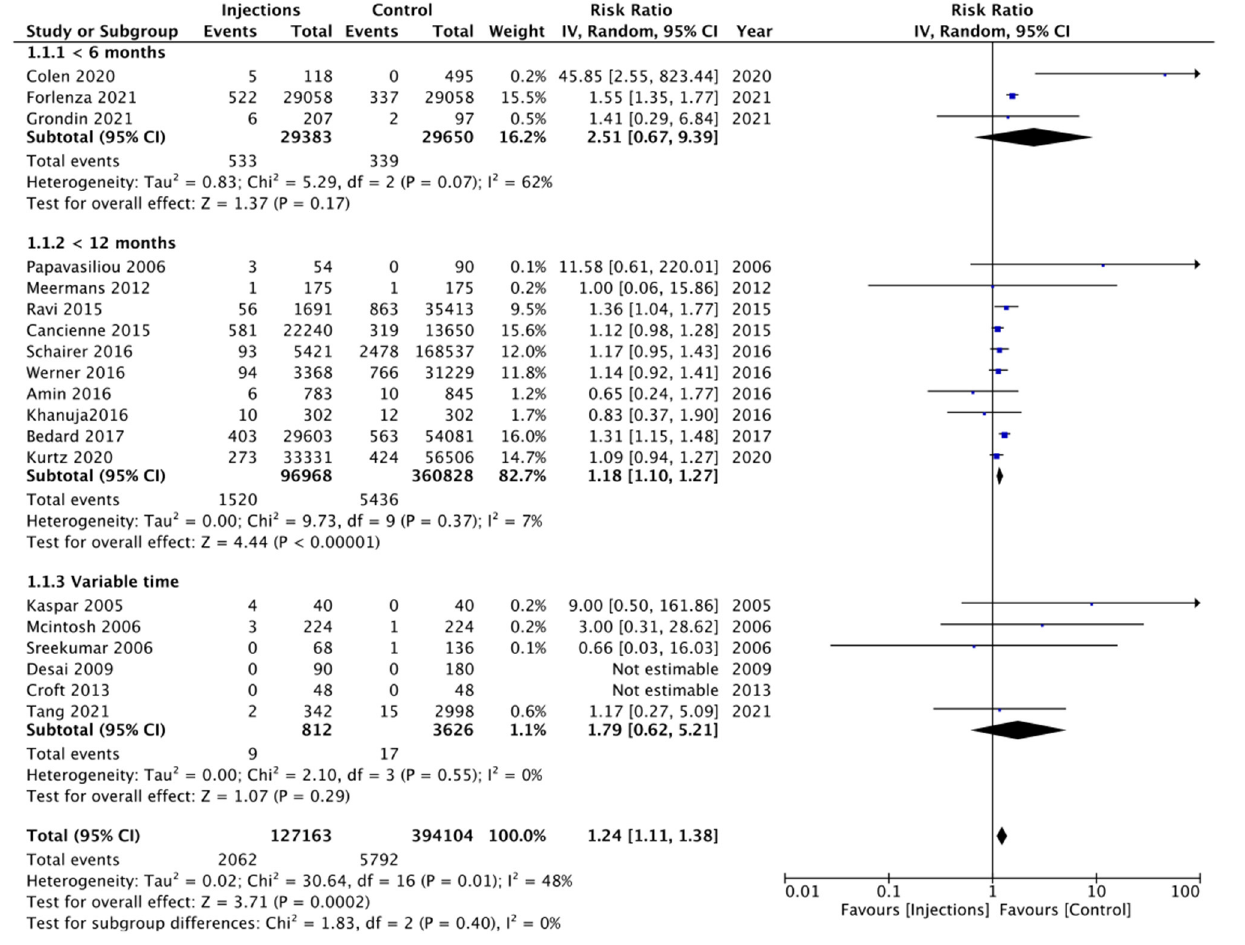
FIGURE 2 | Meta-analysis of all studies reporting PJI between injection and control groups with sub-group analysis based on timing of injection before